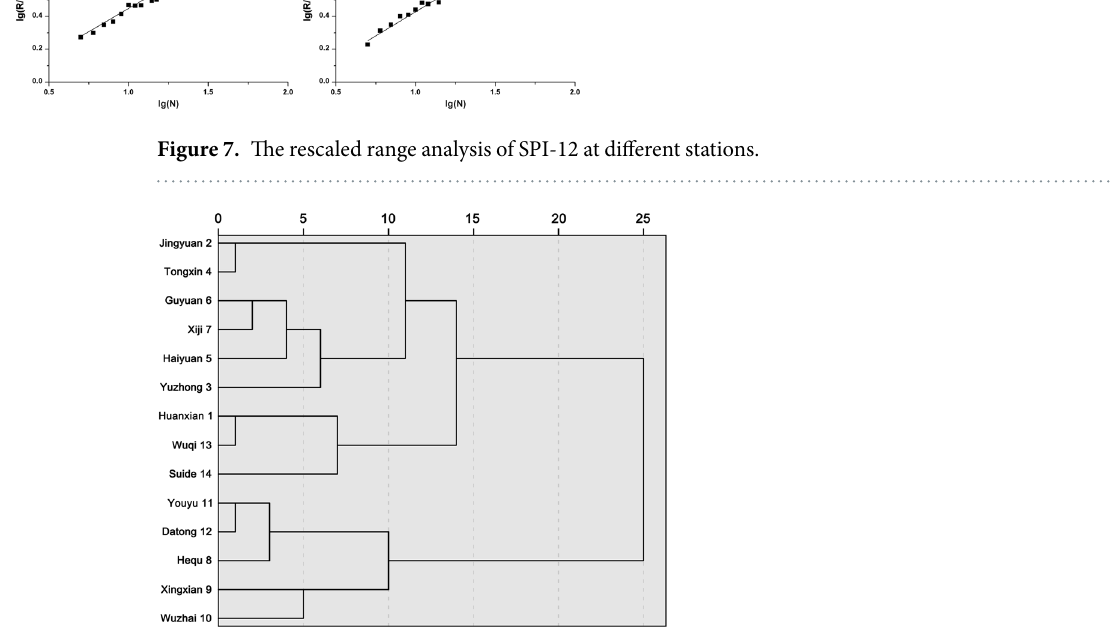
Figure 8. Hierarchical diagram of the cluster analysis of monthly